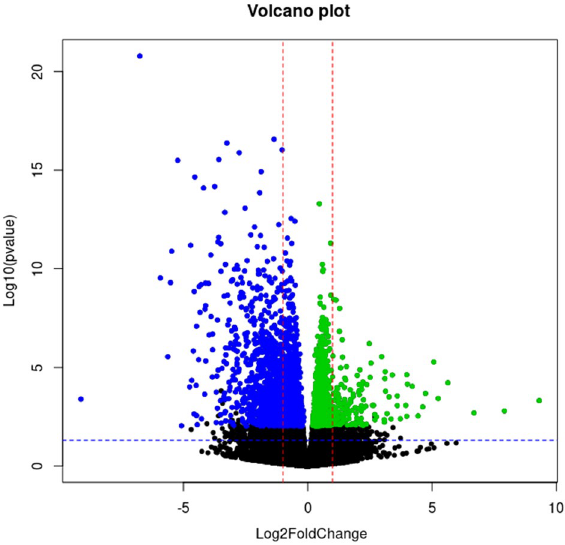
Figure 3. Distribution of differentially expressed genes, with genes more expressed in freshwater resident eels (blue) and genes more expressed in seawater resident eels (green). Black dots represents non-significant differentially expressed genes. X-axis reports the intensity of gene expression change expressed in Log2fold change.